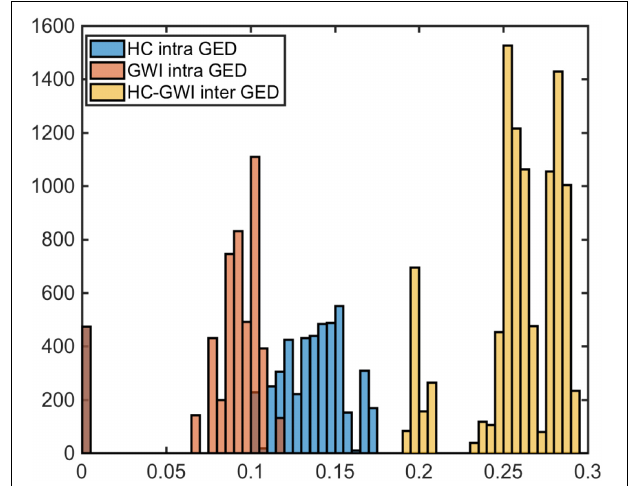
FIGURE 1 | Significantly altered immune circuitry. Graph edit distance (GED) distributions comparison between HC (blue) and GWI (orange) intra GEDs and inter group GEDs